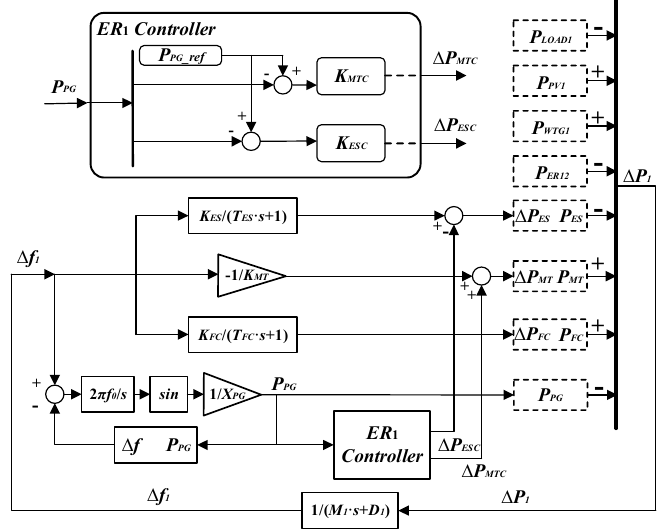
Figure 2. The linearized block diagram of the first microgrid ( MG ) .